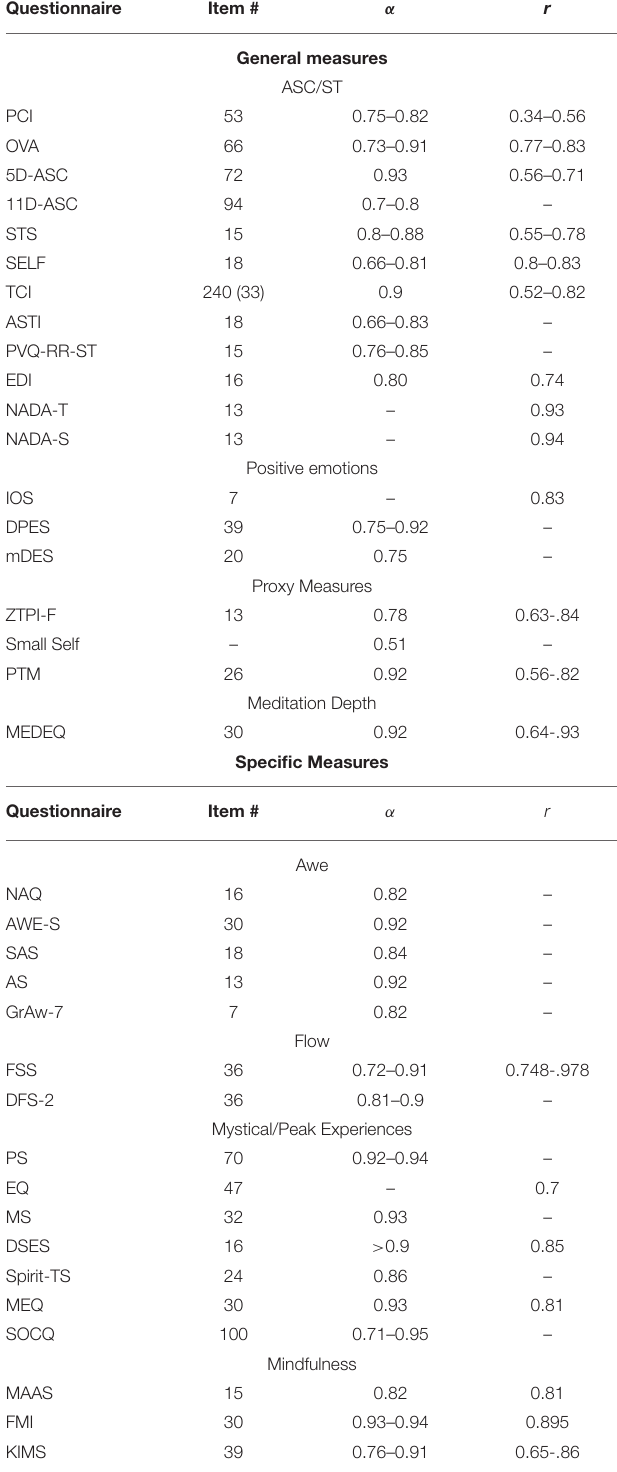
TABLE 1 | Reliability coefficients of internal consistency measured with Cronbach’s alpha and test-retest measured with Pearson’s r, and number of items for questionnaires that measure general self-transcendence (left) and specific constructs of self-transcendence (right).